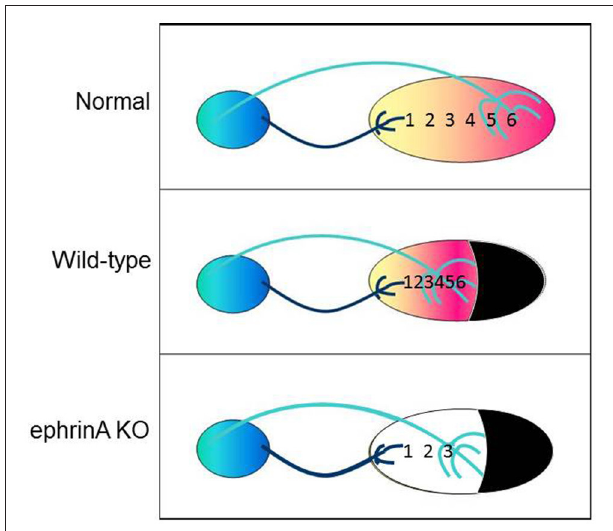
FIGURE 4 | Cartoon illustrating the mapping of nasal to temporal visual field locations 1–6 onto the anterior to posterior axis of SC in normal animals (top) , in animals with compression of the entire visual field onto the smaller SC after neonatal ablation of caudal SC (middle) , and in ephrin knockout animals that failed to compress their retino-SC projections (bottom)